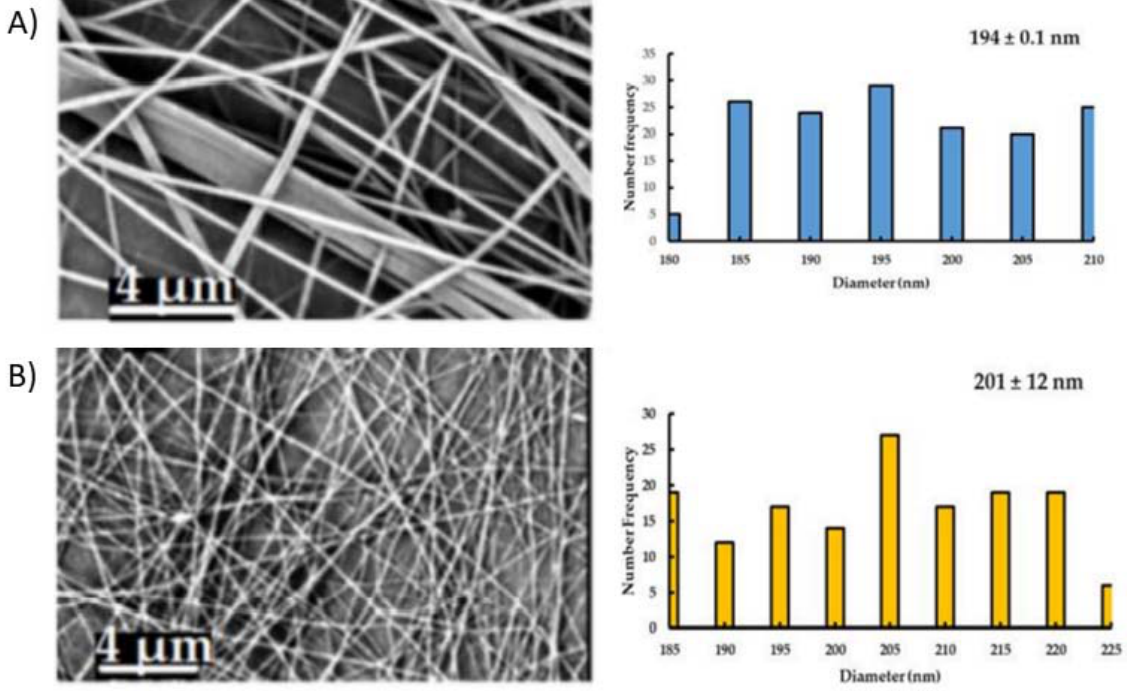
Figure 6. Electrospun fibres prepared by hyaluronic acid (HA) and Polyethylenoxide blend ( A ) and the addition of propolis ( B ): effect of the active compound on the morphology, distribution (e.g., number frequency) and average fibre diameter. Adapted with permission from [79].